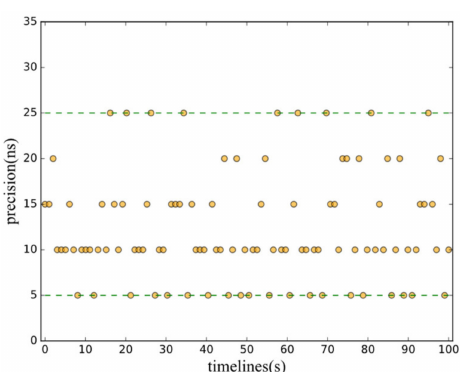
Figure 10. The start-up time of the network.